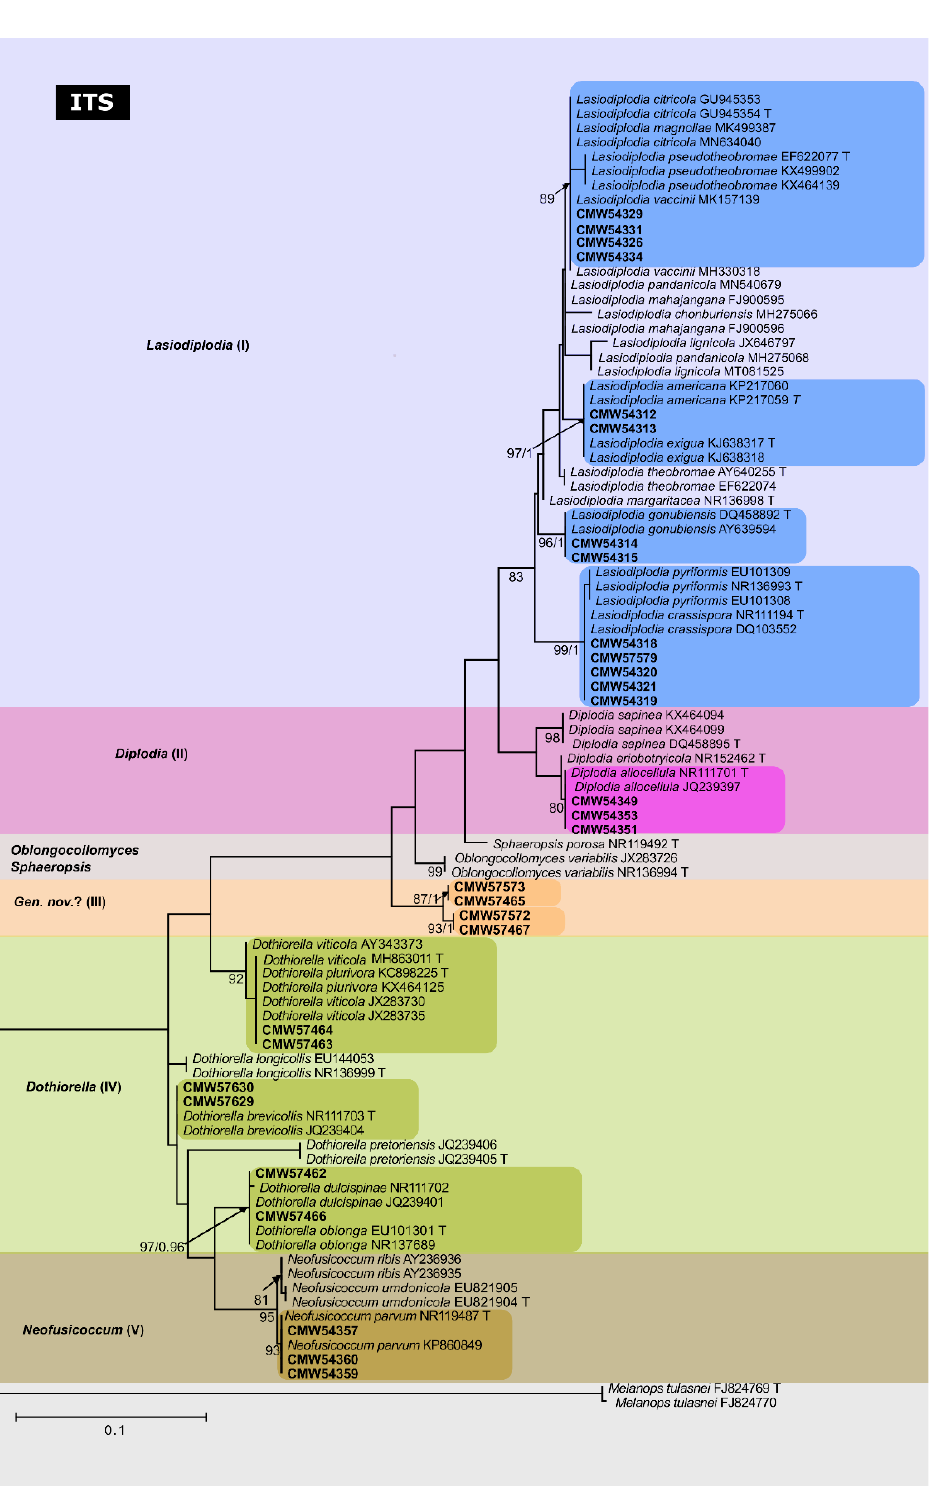
Figure 2. Maximum likelihood (ML) phylogenetic tree resulting from analyses of the ITS dataset. Bootstrap support values above 70% and Bayesian posterior probability values above 0.95 are shown at the nodes. Isolates in bold were obtained in this study. The tree was rooted to Melanops tulasnei.